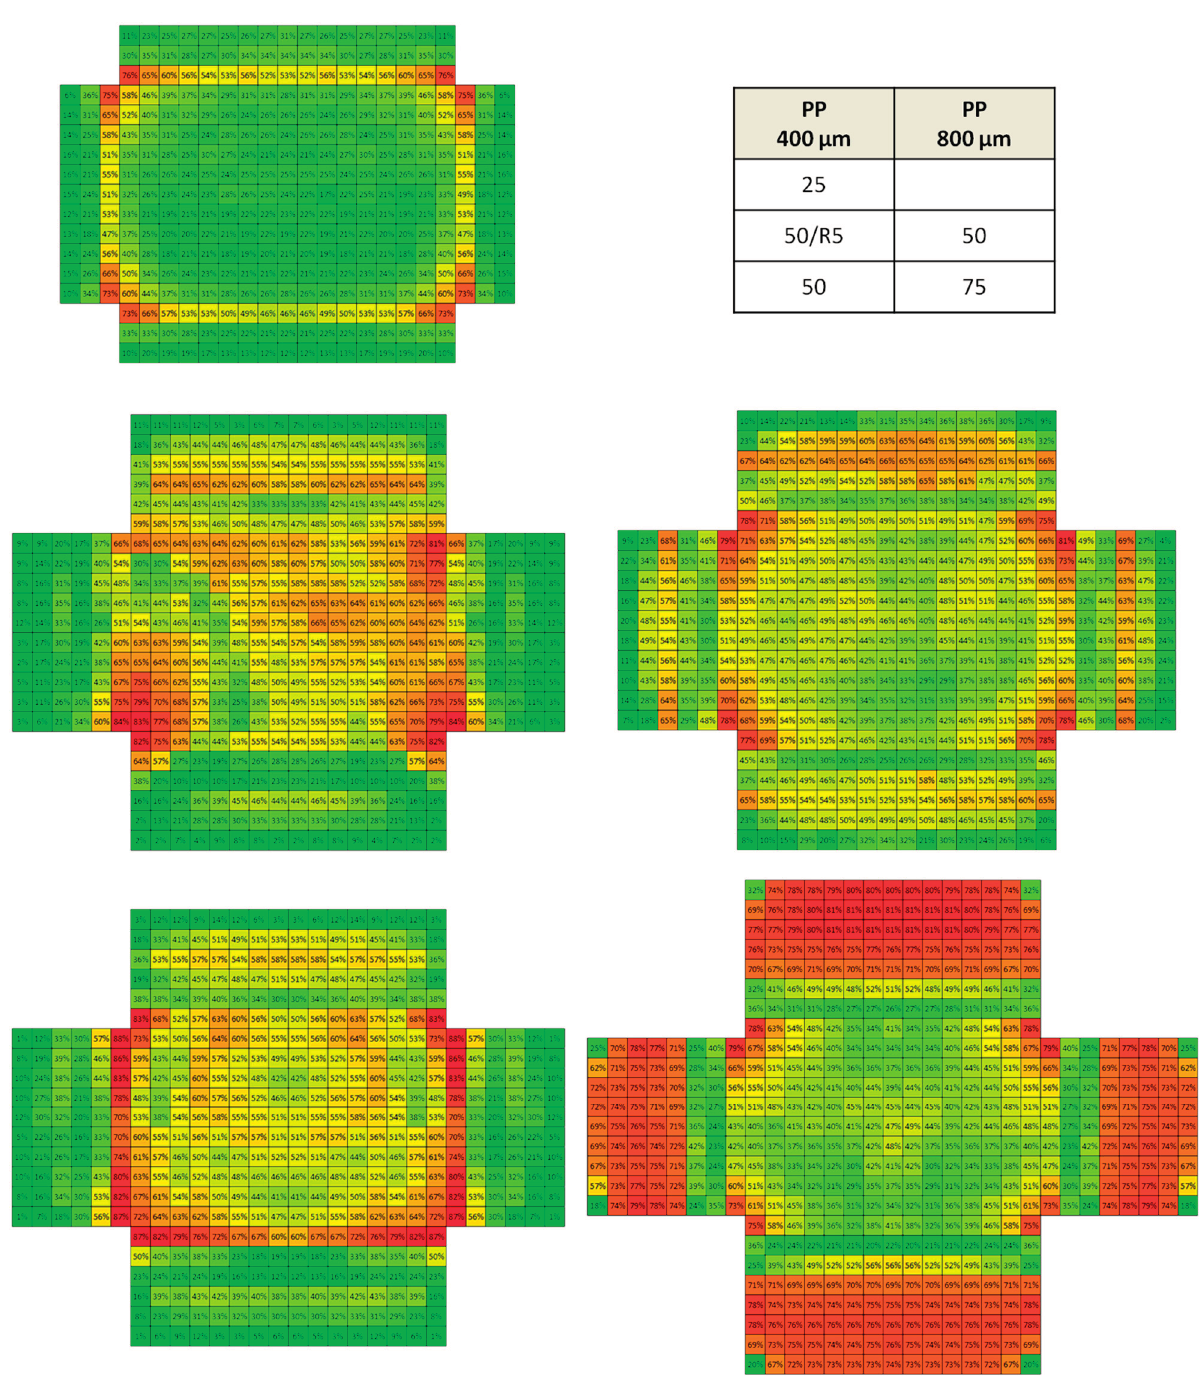
Figure 2. Visual representation of percentage thinning in 25-, 50/R5-, 50-, and 75-trays of the thin ( left ) and thicker ( right ) PP